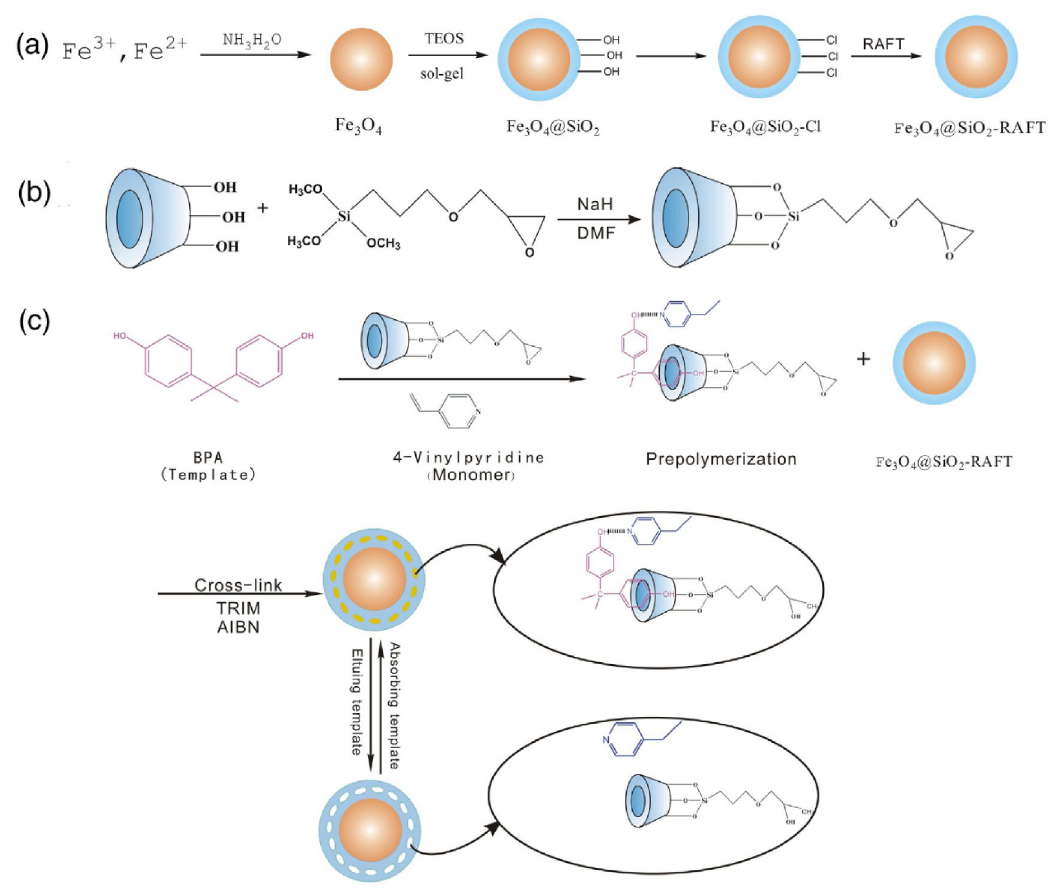
Fig. 9. Synthesis route of surface-imprinted core-shell magnetic beads and their application for the extraction of BPA